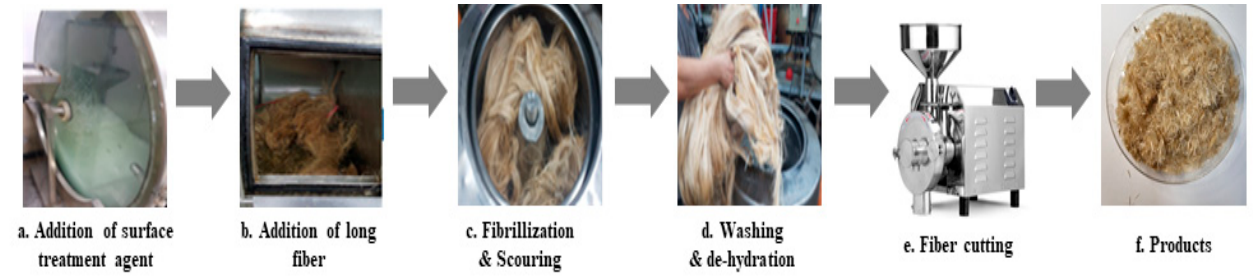
Figure 7. Process of surface treatment for natural fibers.